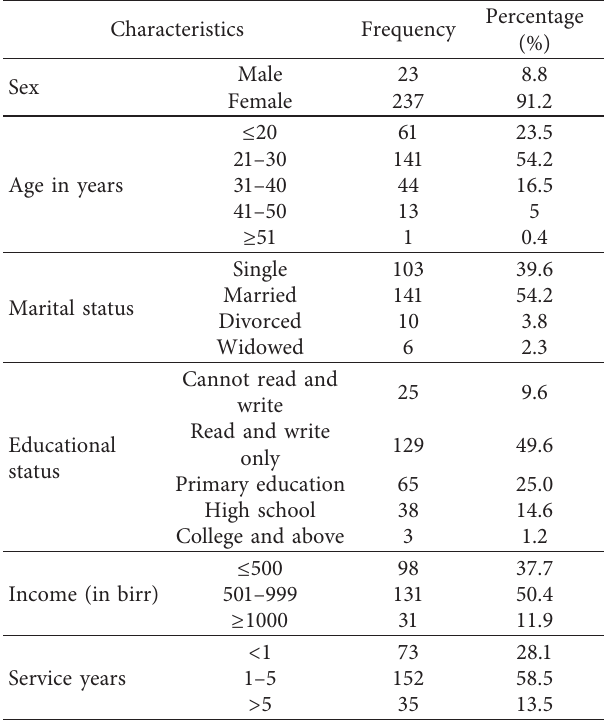
Table 1: Socio-demographic characteristics of street food handlers in Jimma town, Southwest Ethiopia ( n � 260), Oct–Dec